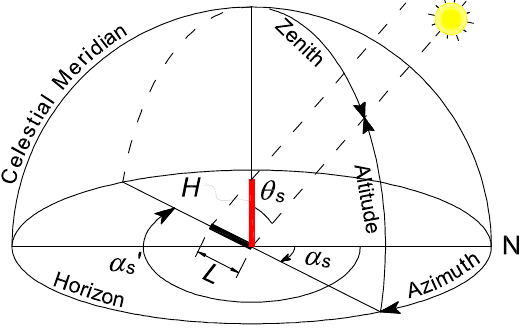
Figure 1. Spherical geometry for solar azimuth and zenith angles calculation.